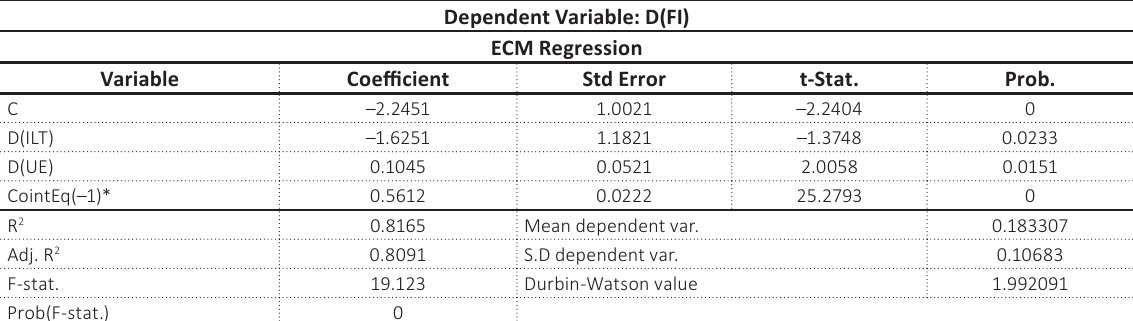
Table 7. Hypotheses testing